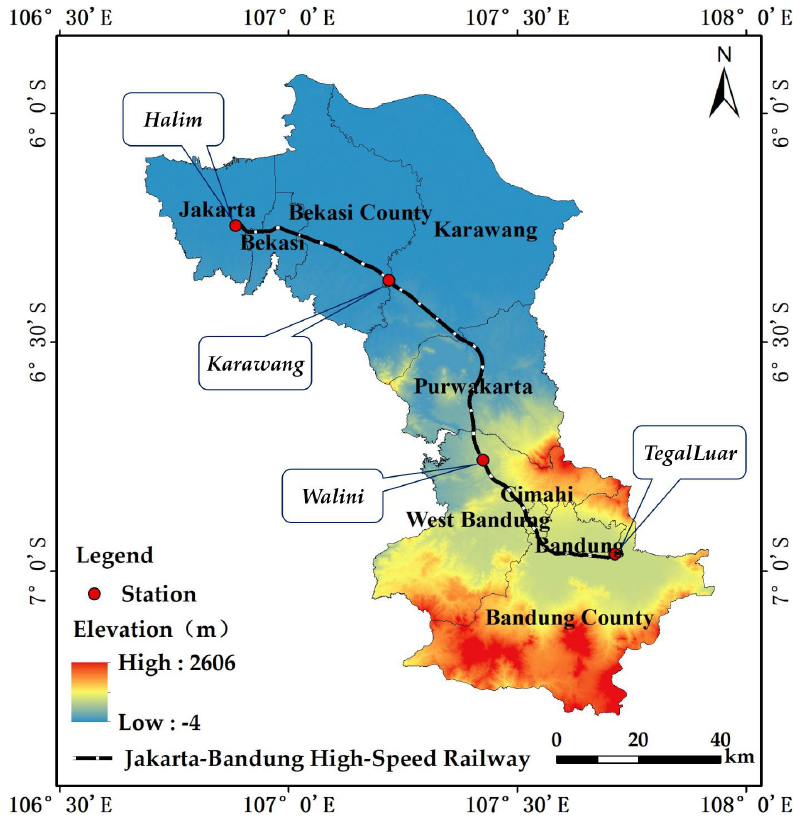
Figure 1. The location of the study